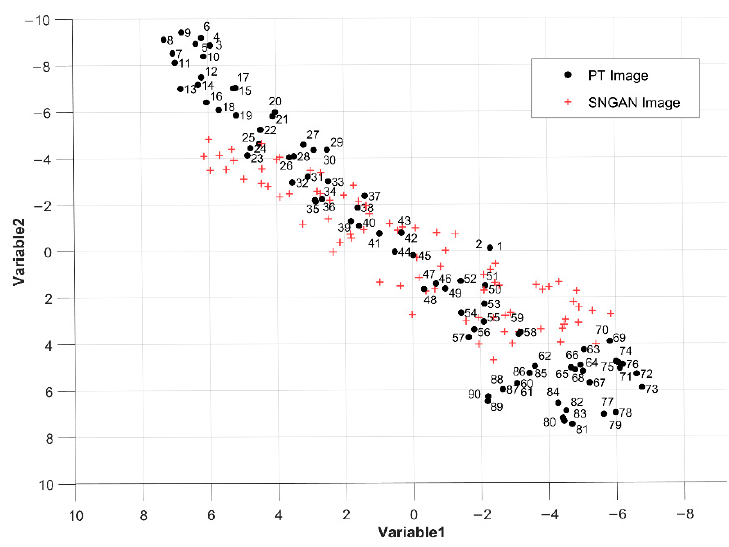
Figure 11. The t-SNE visualization of PT thermograms and SNGAN thermograms.